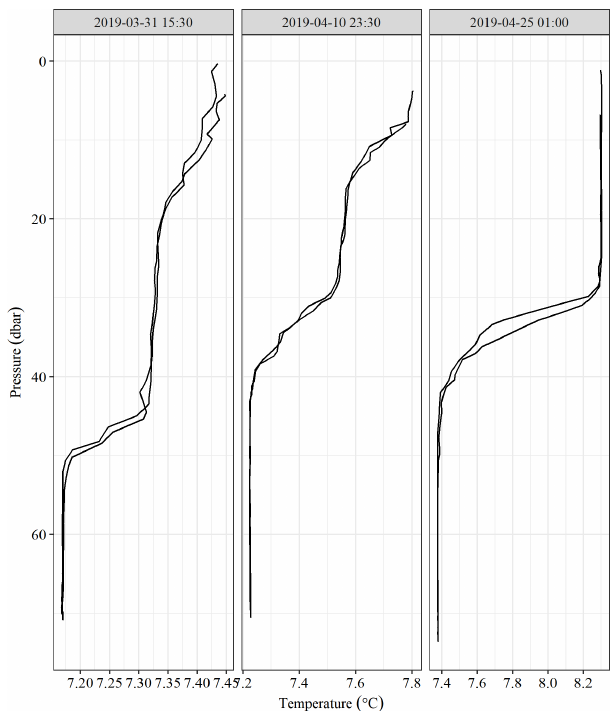
Figure A1. Example vertical temperature profiles recorded by the